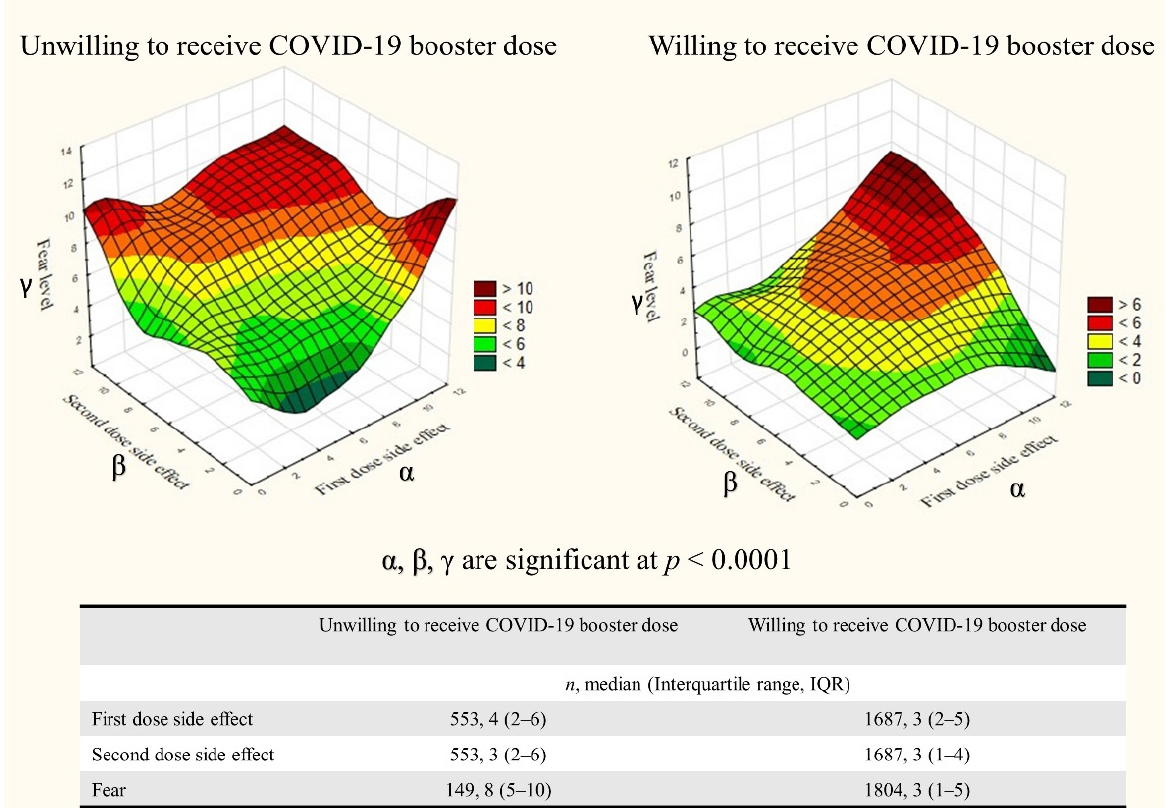
Figure 3. Differences between the side effects of the first and second dose of COVID-19 vaccine ( α and β , respectively) and fear ( γ ) between individuals (willing vs. unwilling) to receive the booster dose.